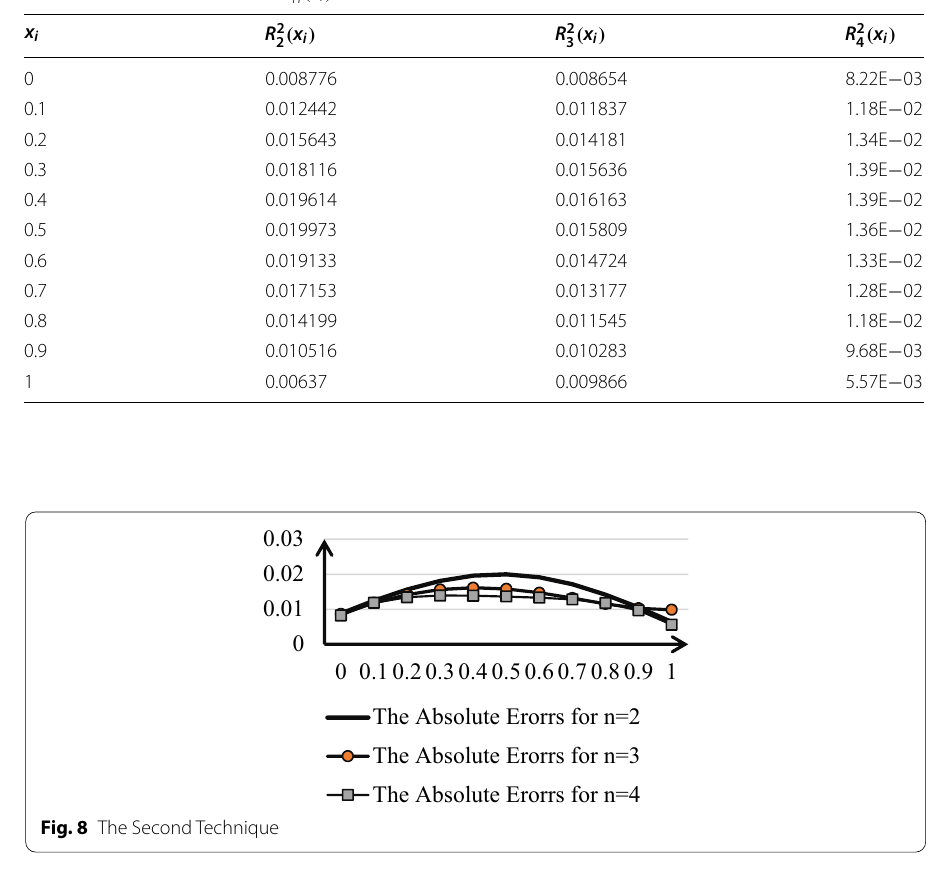
Table 8 The absolute errors R 2 n ( x i ) for n = 2,